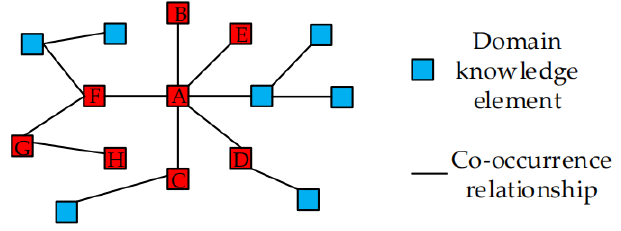
Figure 2. Co-word co-occurrence network of domain knowledge elements.